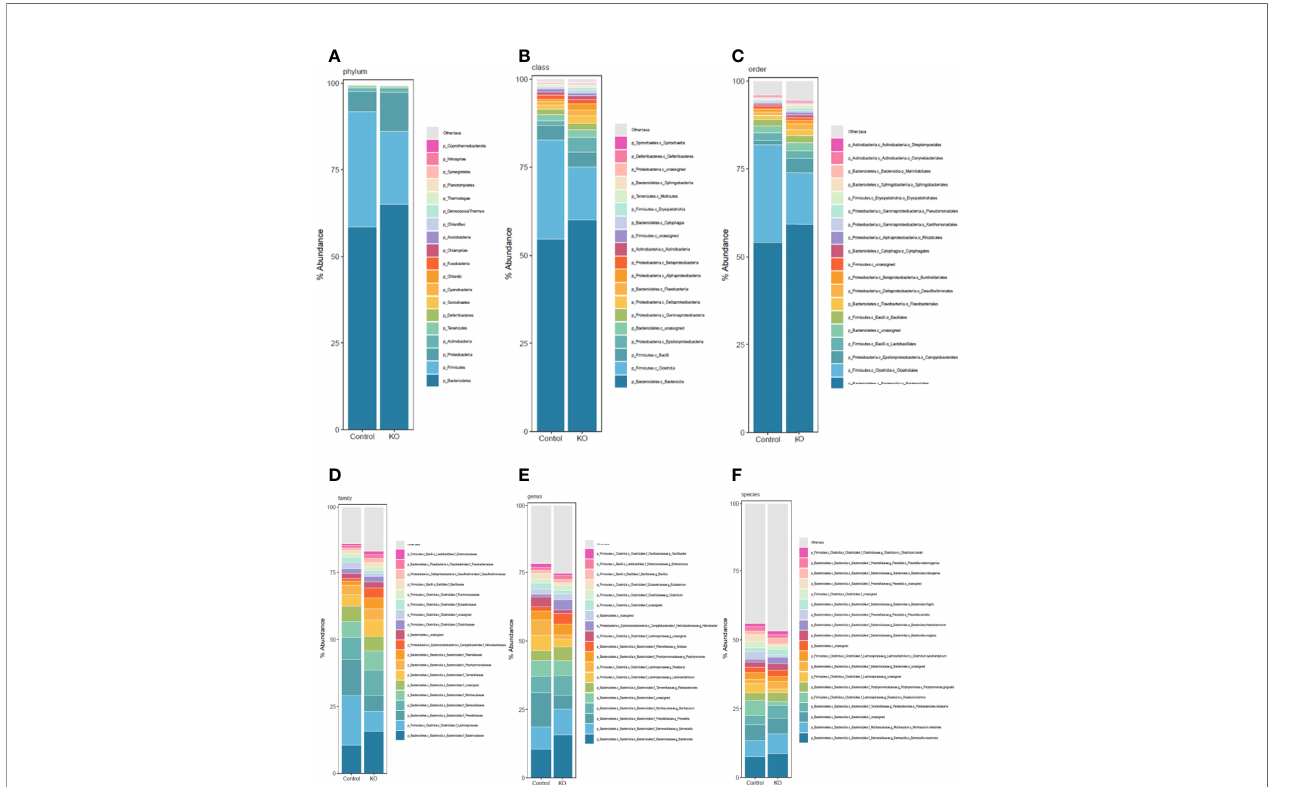
FIGURE 3 | Taxonomic composition distribution histograms of gut microbiota from NHE3 IEC-KO and control mice. Composition of gut microbiota at the phylum (A) , class (B) , order (C) , family (D) , genus (E) , and species (F) levels, from NHE3 IEC-KO and control mice. N =